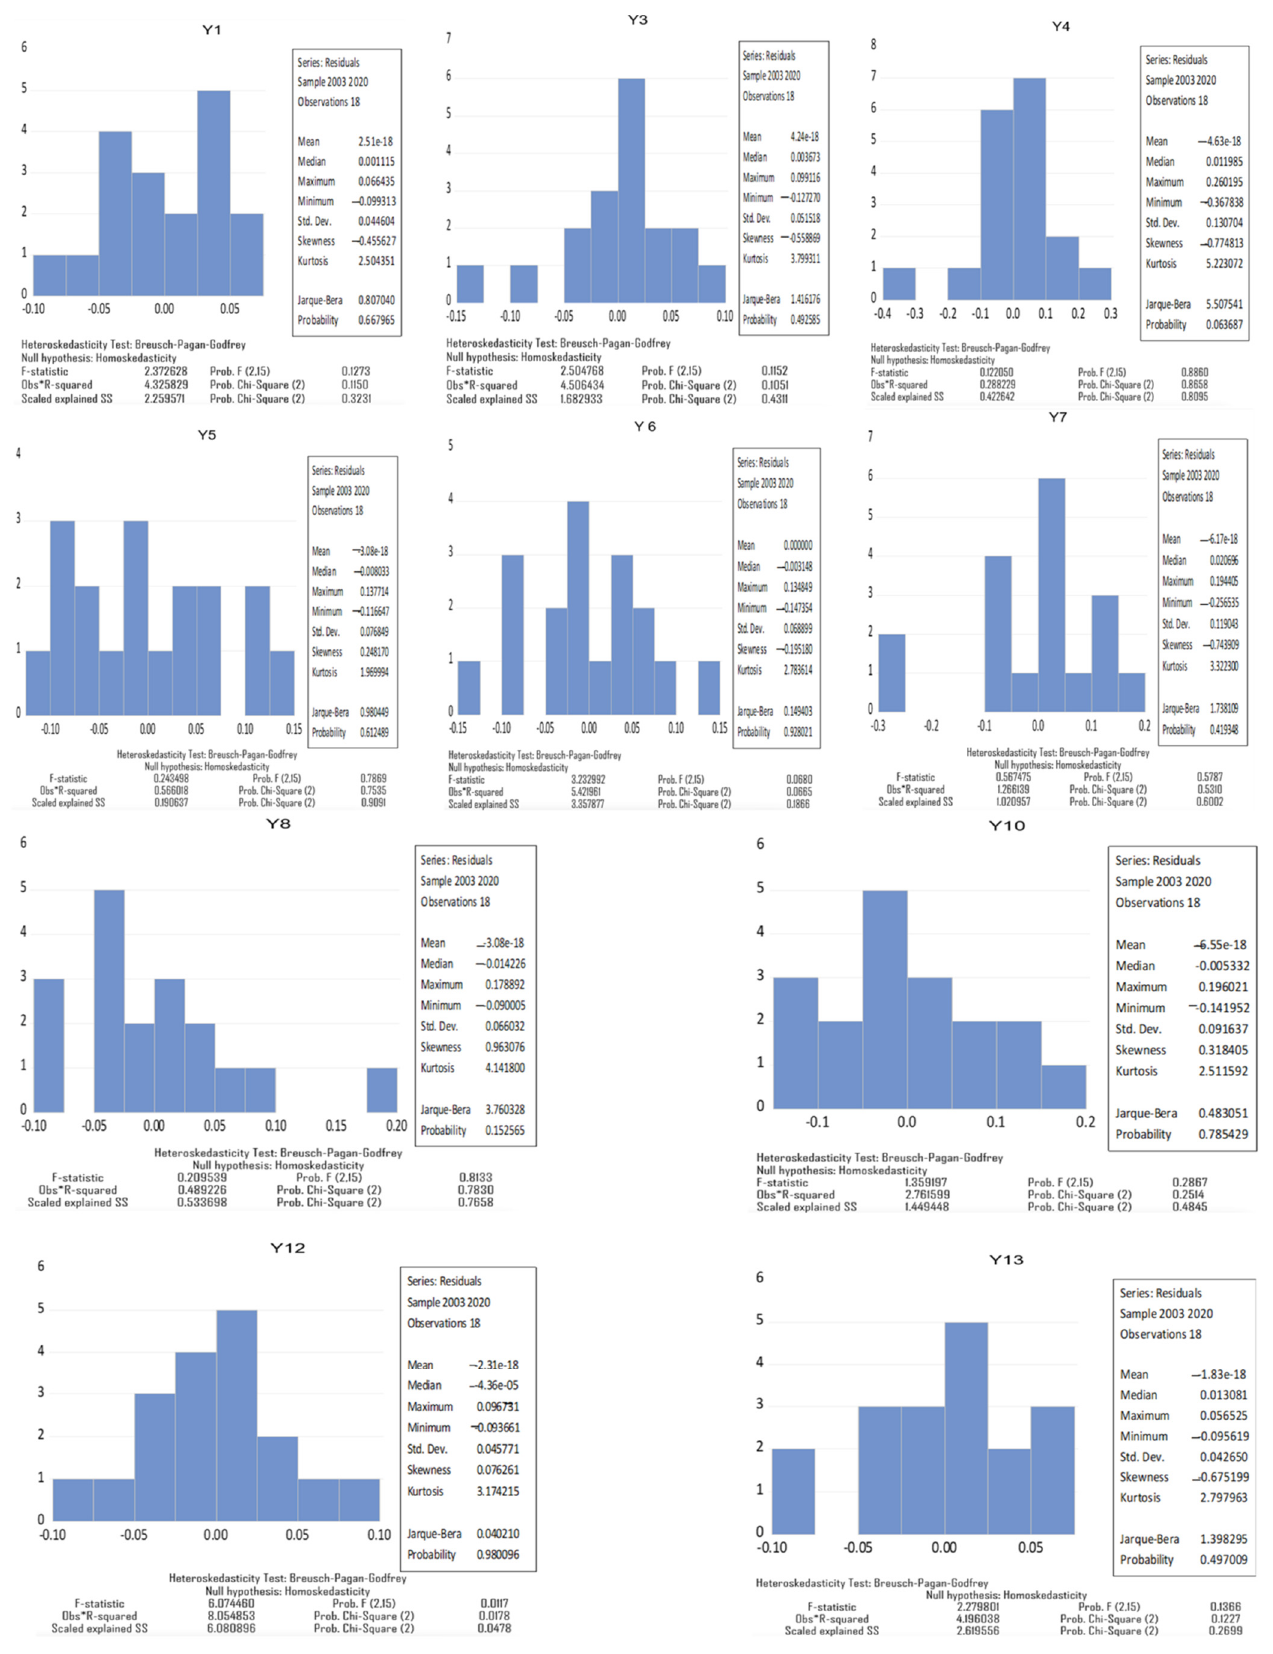
Figure 6. Results of the Breusch–Pagan–Godfrey heteroskedasticity test for Test 2.